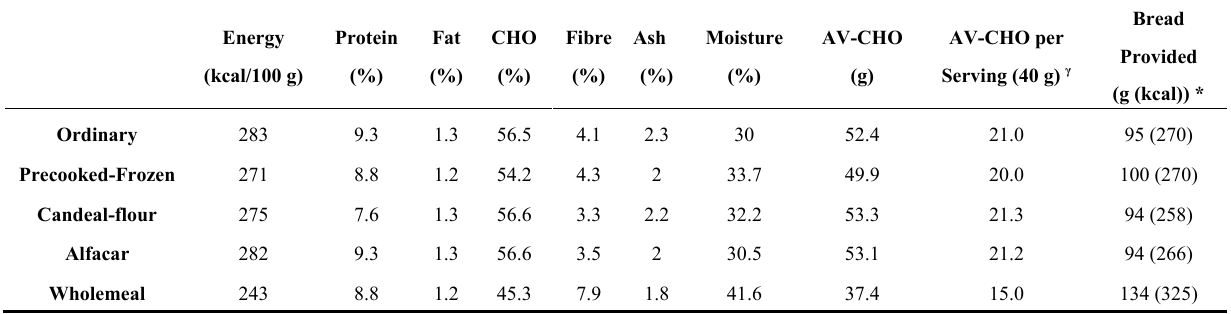
Table 1. Composition of the different tested